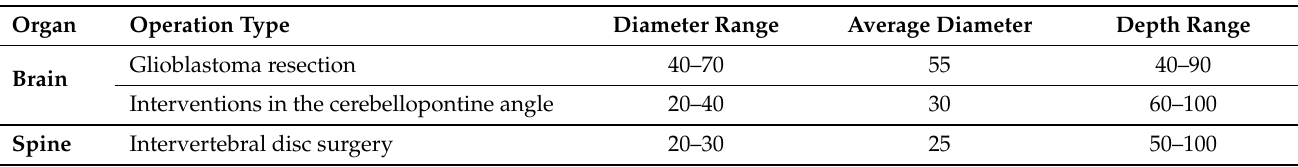
Figure 2. Five different artificial patient surgical site models with a 50mm deep operative corridors. “Circ flat anatomy”, shown in ( a ), contains a rather flat topology. “Circ angled anatomy” in ( b ) features a network of arteries, tissue furrows and undercuts, which are set at an angle in the corridor. “Circ artery” ( c ) has the same flat topology as in ( a ) at the bottom of the operative corridor, but adds an artery spanning the operative corridor. ( d ) shows a topology consisting of a mixture of arteries, tissue furrows, undercuts, dominated by a large overhang protruding from the channel wall. This model is called “circ overhang”. The model in ( e ) combines features from ( b , d ), set in an operating corridor with deformed elliptical cross-section, hence its name: “elliptical channel”. Table 1. Operation channel diameters for groups of lesions that are of particular interest in microsurgery. We used these values as a basis for the design of our operation channel models. All values are given in millimeters. Data provided by Carl ZEISS Meditec